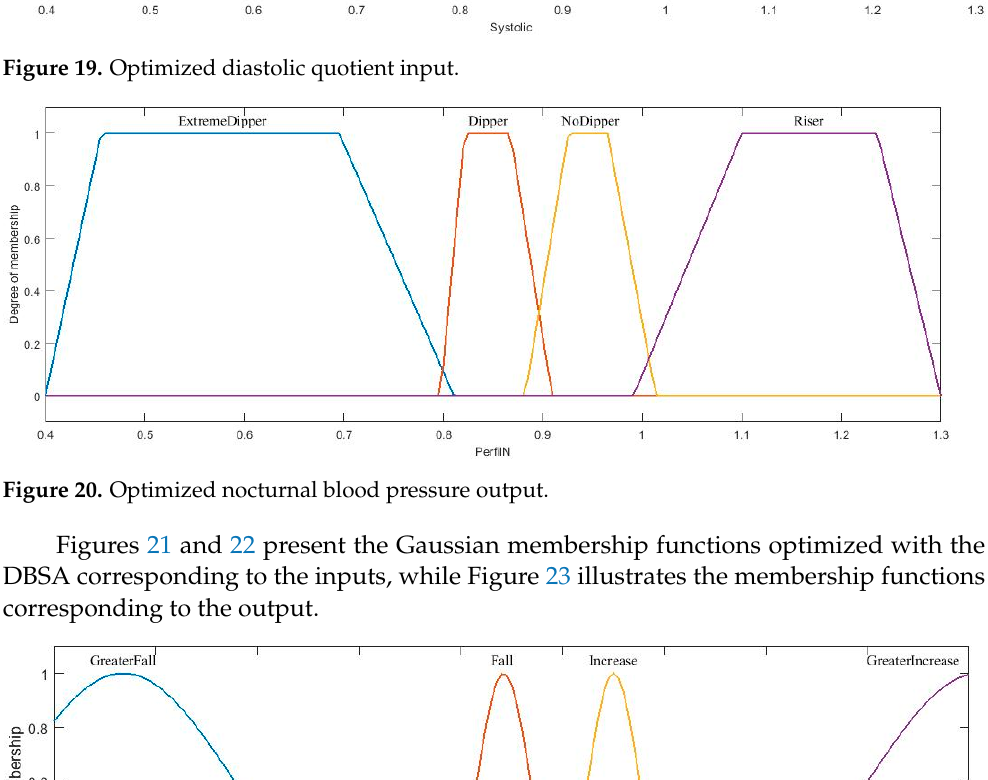
Figure 22. Optimized diastolic quotient input. Figure 23. Optimized nocturnal blood pressure level output. Table 11 presents the parameters used by the optimized and non-optimized fuzzy classifier, being a, b, c, and d for each parameter used in the trapezoidal membership func- tions.